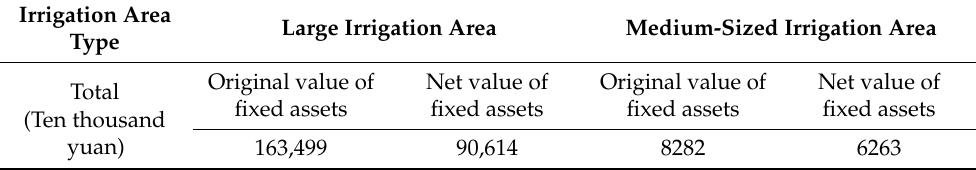
Original and net value of fixed assets of water conservancy in various types of irrigation